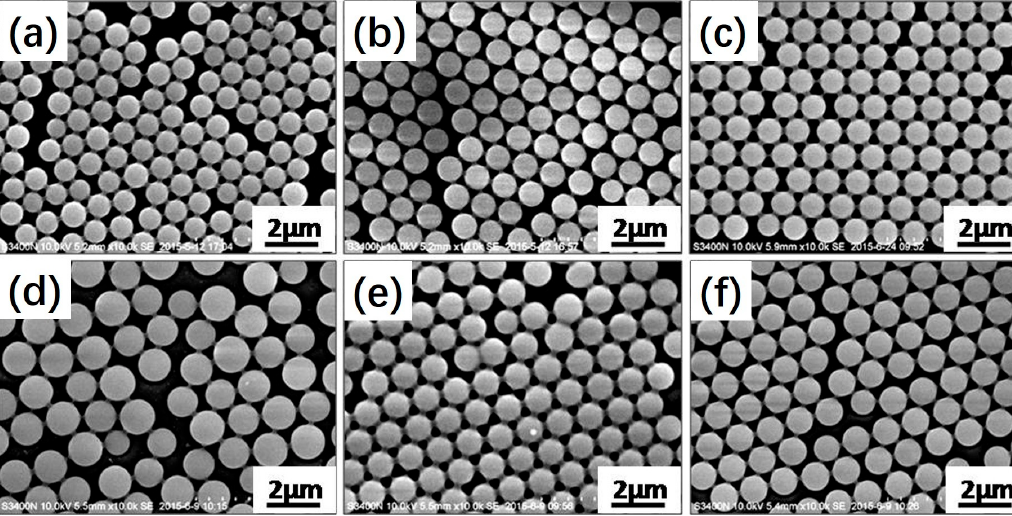
Figure 4. SEM images of polymeric microspheres prepared by photoinitiated RAFT dispersion polymerization of MMA at different S , S ′ -bis( α , α′ -dimethyl- α″ -aceticacid) trithiocarbonate (BDMAT) concentrations with either ( a – c ) 2 or ( d – f ) 6 wt % MAA: ( a , d ) 0.25 wt % BDMAT, ( b , e ) 0.5 wt % BDMAT, ( c , f ) 0.75 wt% BDMAT. Table 2. Synthesis and characterization data for polymeric microspheres prepared by photoinitiated RAFT